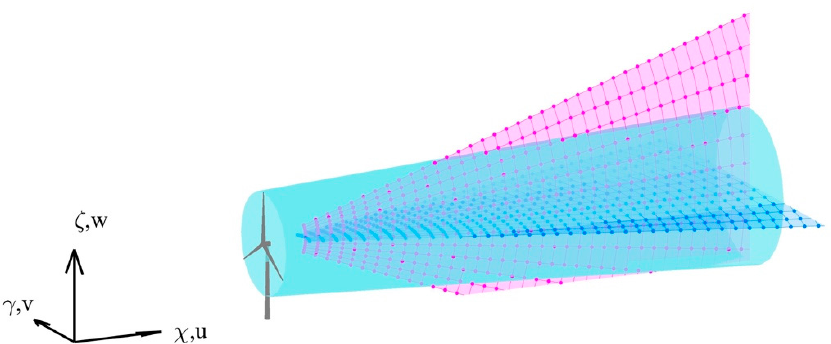
Figure 1. Illustration of cross-measurement trajectories. A horizontal PPI scan is shown in dark blue, and a vertical RHI scan is shown in pink. The wake volume is indicated in light blue.